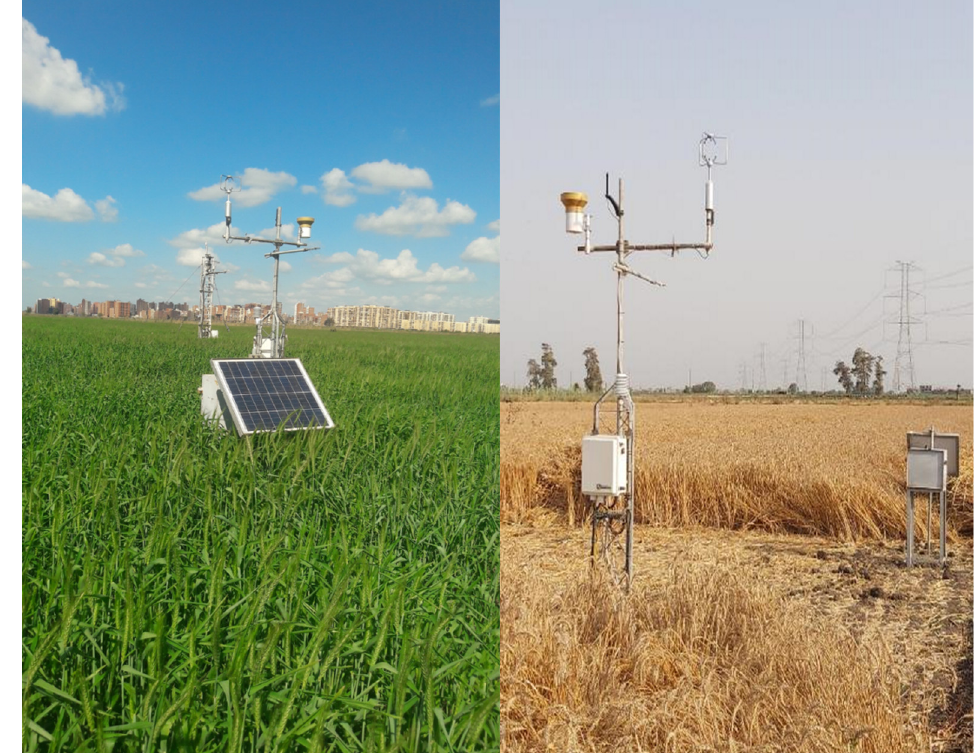
Figure 2. The energy balance tower in Sids Station.